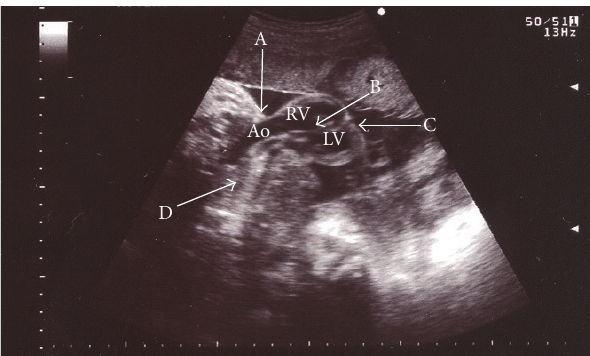
Figure 3: The newborn 5 minutes after birth. C: the ectopic heart positioned outside the thoracic cavity; F: supraumbilical